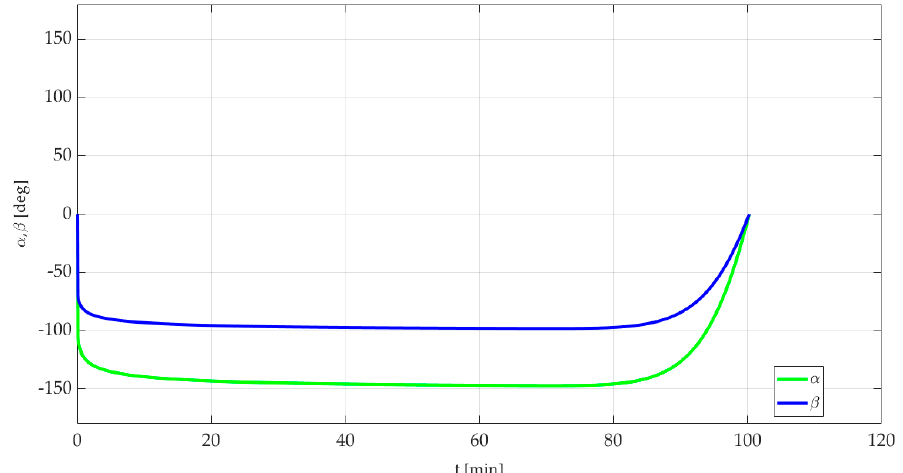
Figure 13. Change in thrust control angles in time (SBSS scenario).